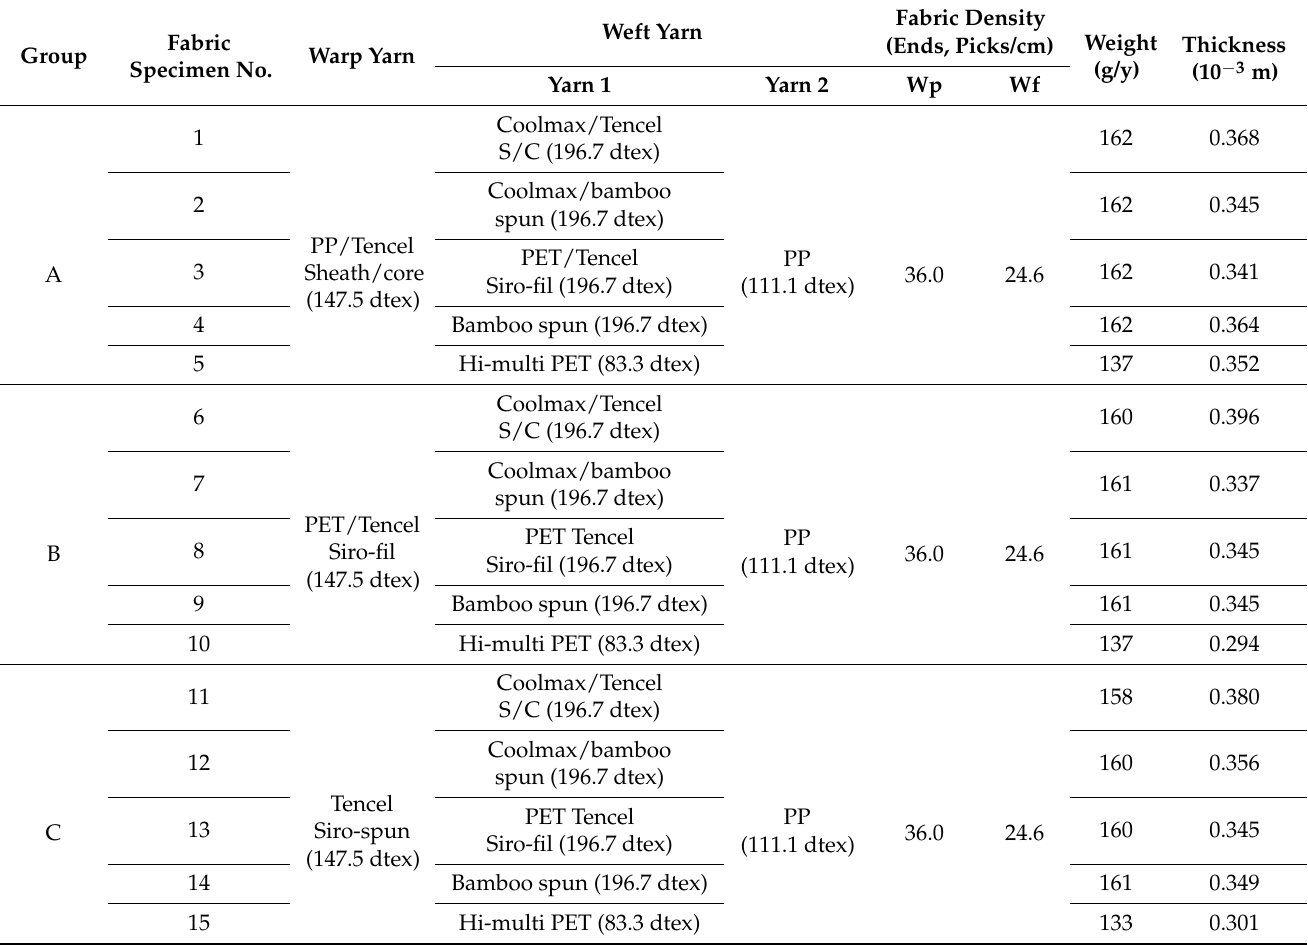
Table 3. Specification of the fabric